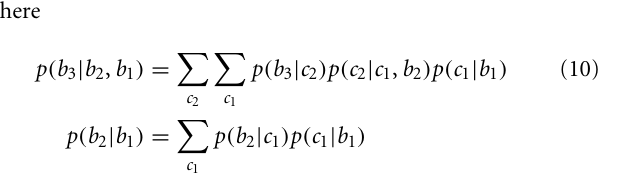
at about 350ms. After the response, an inference is made as to whether response accumulation was correct on that trial ( c t = 1). If it was deemed correct then the threshold remains low on the next trial. Otherwise it is increased (corresponding to p = β [0]), resulting in a longer RT on trial t + 1.This process is referred to as Bayesian Adaptive